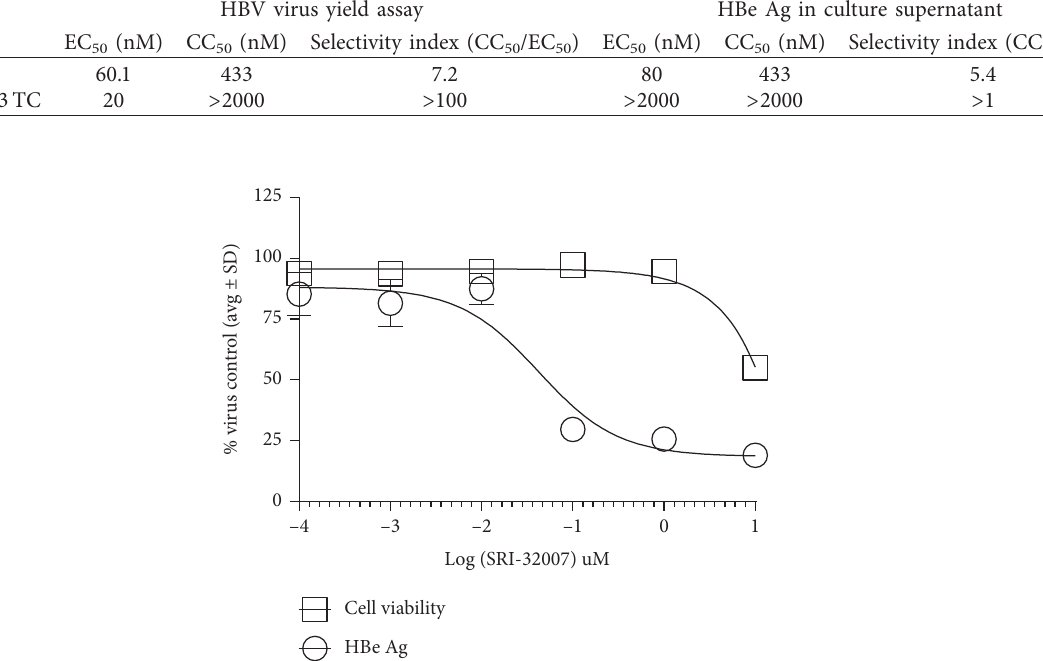
Figure 2: Antiviral activity of SRI-32007 against HBV genotype B in Huh7 cells. Huh7 cells transfected with HBV genotype B plasmid were treated with different concentrations of SRI-32007 in 96 wells for six days followed by measurement of HBe antigen in the culture supernatants by ELISA and cell viability using MTS. HBe Ag levels in the treated samples and cell viability normalized to the untreated samples (average ± standard deviation from triplicate samples) are shown in the figure.